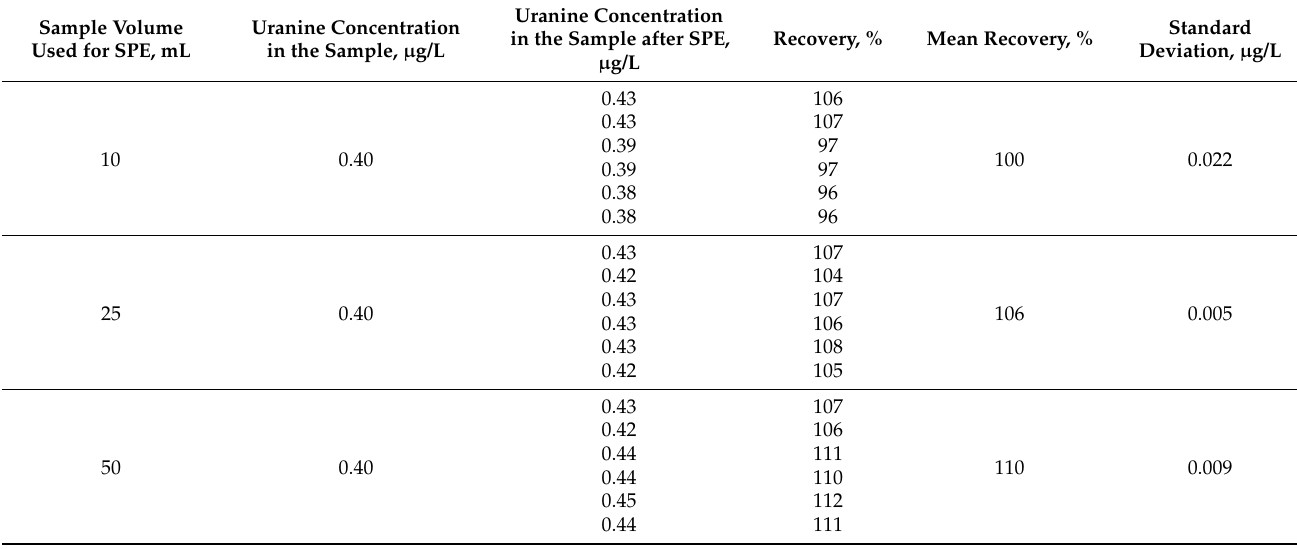
Table 2. Results obtained when selecting the optimal sample volume for SPE extraction. Sample Volume Used for SPE, mL